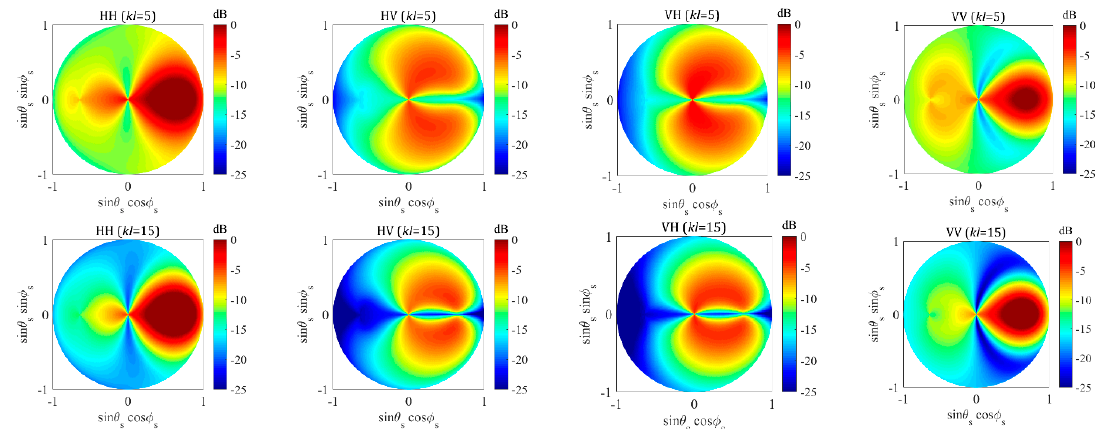
Figure 4. Hemispherical plots of polarized bistatic scattering coefficients HH, HV, VH, and VV, with exponentially correlated surface θ i = 40 ◦ , k σ = 1.0, m v = 20%. First row: k (cid:96) = 5. Bottom row: k (cid:96) = 15.